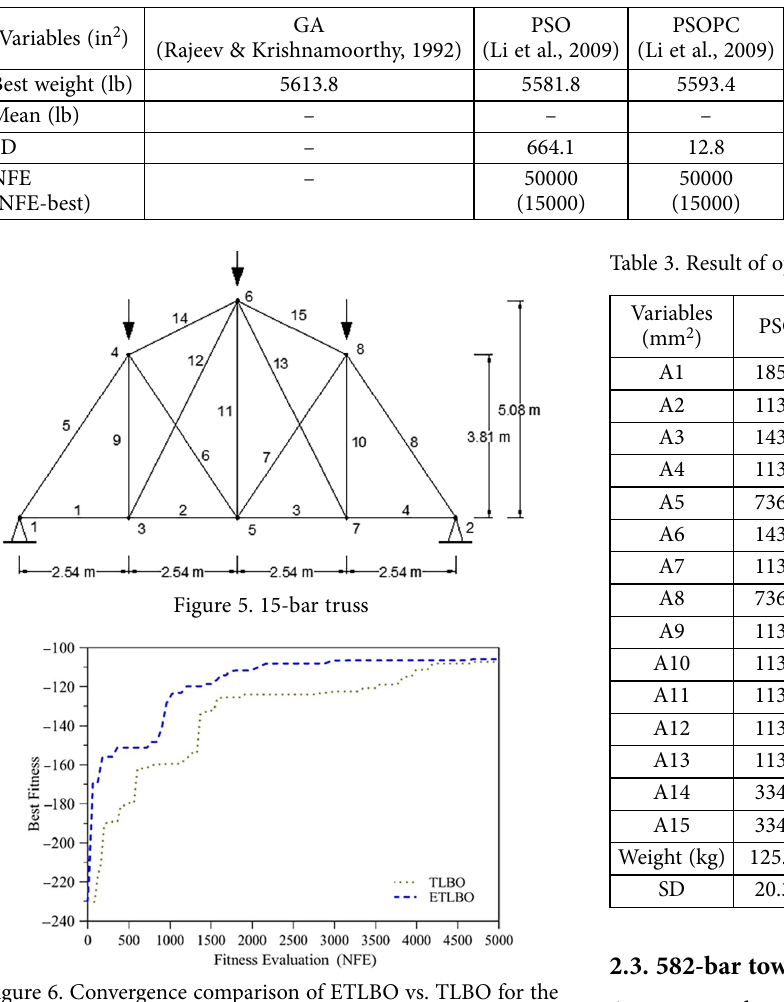
Figure 4. DI traces of ETLBO vs. TLBO for the 10-bar truss Table 2. Comparison of results algorithm in literature for the 10-bar truss example